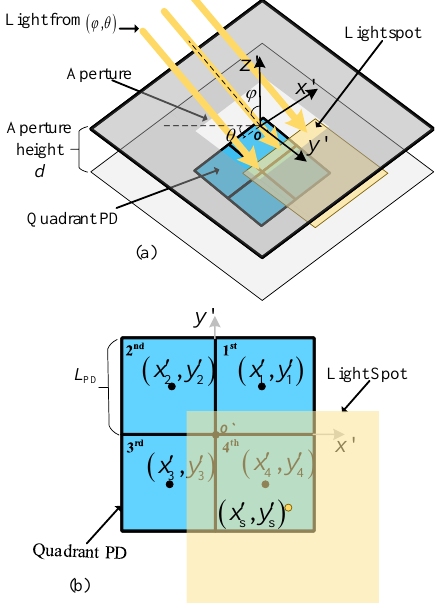
Figure 1. QADA ( a ) receiver structure; ( b ) an example of the overlap between the light spot and the quadrant